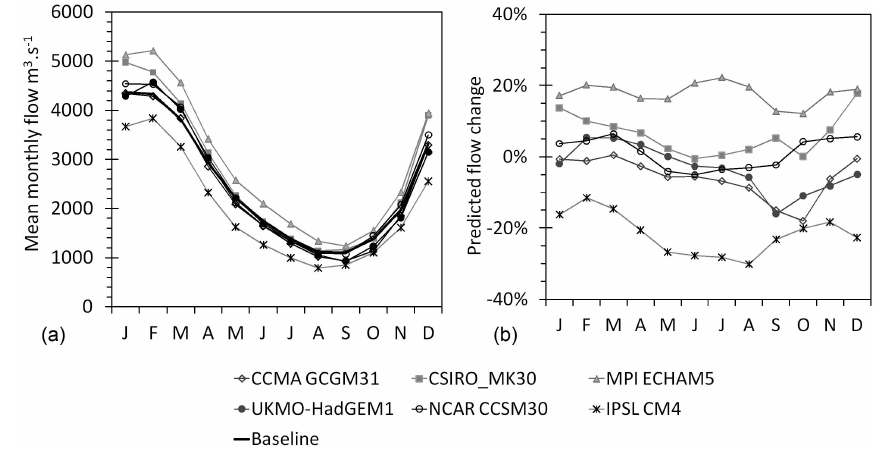
Figure 9 : Projected changes in mean monthly river flow under a mean global 593 temperature rise of +2°C from six priority GCMs in the Rio Grande basin (a) and 594 Fig. 9. Projected changes in mean monthly river flow under a mean global temperature rise of +2 ◦ C from six priority GCMs in the Rio relative to the detrended 1961-1990 baseline or control run (b). 595 Grande basin (a) and relative to the detrended 1961–1990 baseline or control run (b) . 596